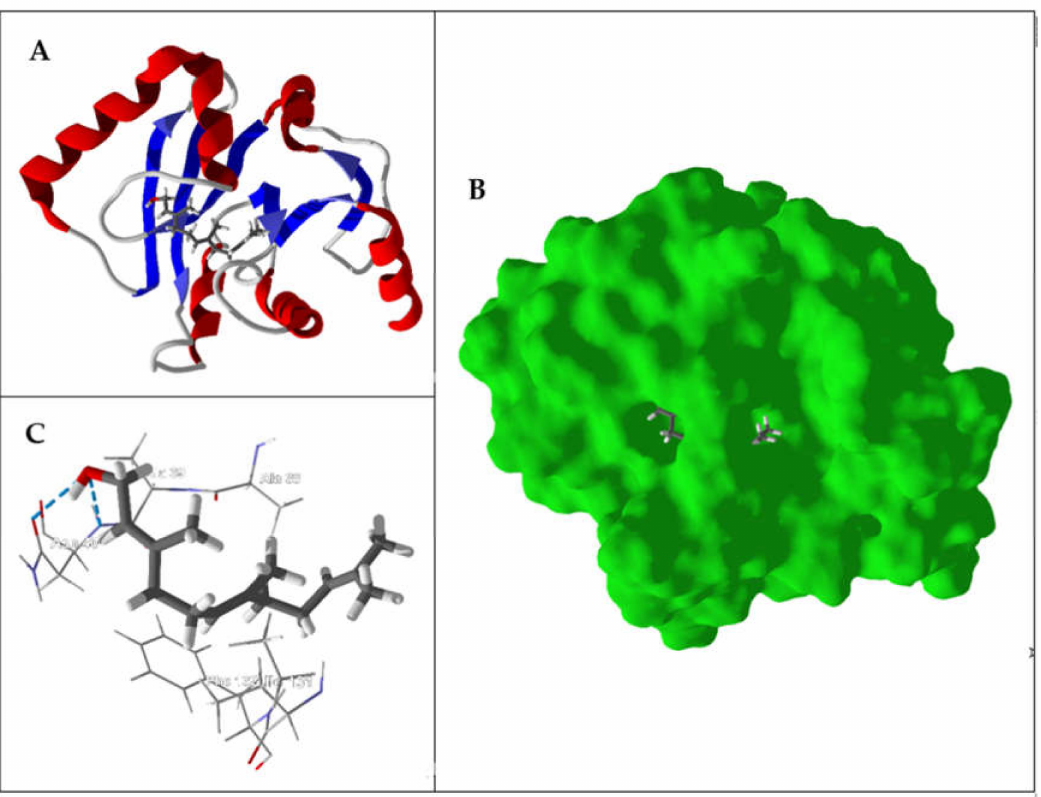
Figure 4. Lowest-energy docked pose of ( E , E )-farnesol with SARS-CoV-2 ADP ribose phosphatase (PDB: 6W02). ( A ) Ribbon structure of the enzyme and the docked ligand. ( B ) Solid structure of the enzyme showing ( E , E )-farnesol in the binding cleft. ( C ) Amino acid residues in proximity to the docked ( E , E )-farnesol (hydrogen bonds are indicated with blue dashed lines).